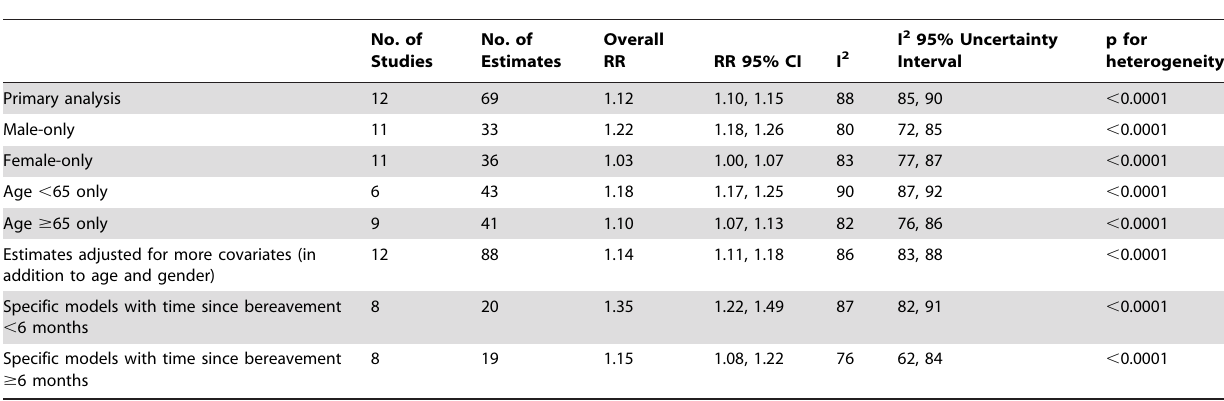
Table 1. Result of the Primary Meta-Analysis and Stratified Meta-Analyses.